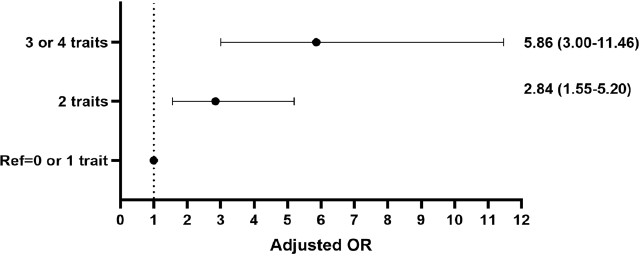
Figure 3. Adjusted associations between the number of metabolic traits and MAFLD-HCC on multivariate logistic regression